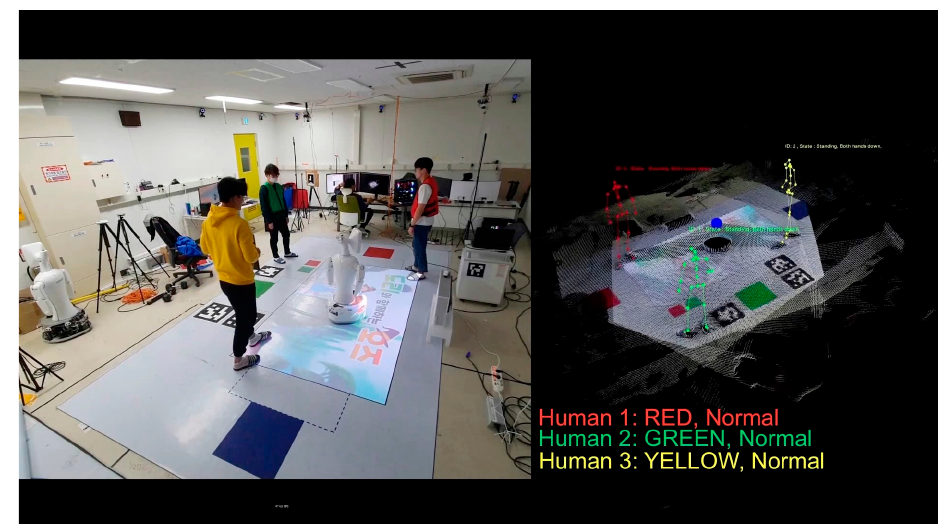
Figure 6. Example of identifying three subjects and a robot.